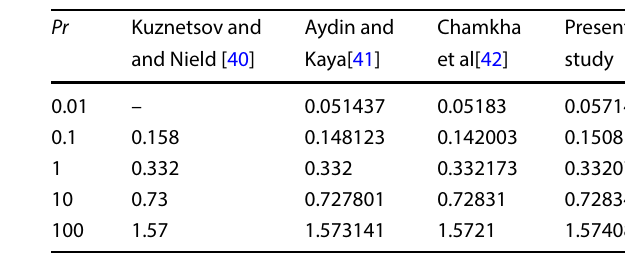
Table 2 Results validation with the previous studies for (− 𝜃 � ( 0,0 )) with 𝜆 = 0 and 𝜙 = 0 for different Pr